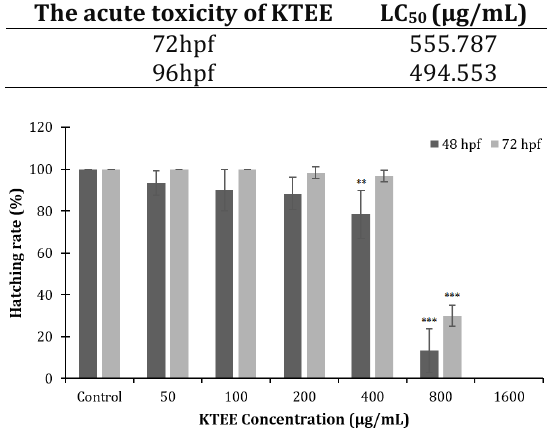
Figure 2. The hatching rate of the zebrafish embryo after being exposed to various concentrations of KTEE at 48 HPF and 72 HPF. Significant different with normal groups *** P<0.001; ** P<0.01 (Mean±SD).